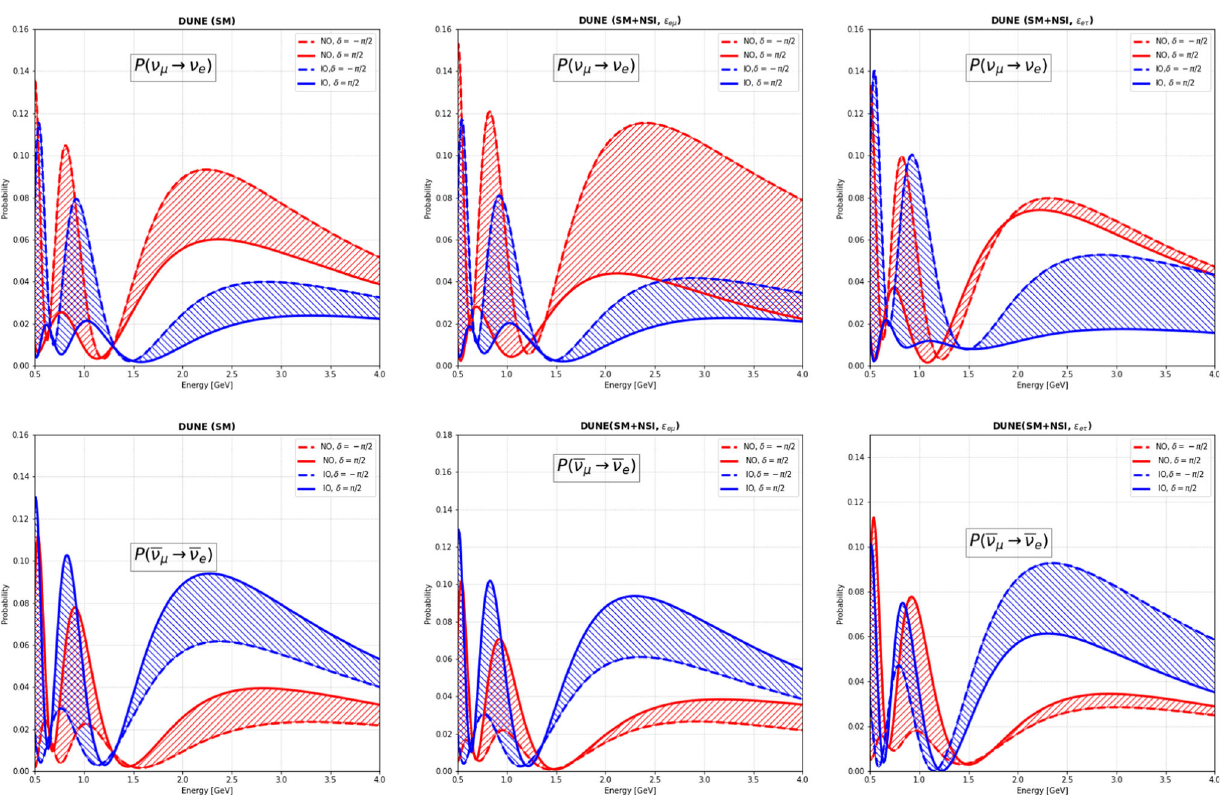
Fig. 6 Probability Plots for DUNE in SM (left) and SM+NSI scenario with NSI arising from e − μ sector (middle) and e − τ sector (right) for ν (top panel) and ¯ ν (bottom panel) mode